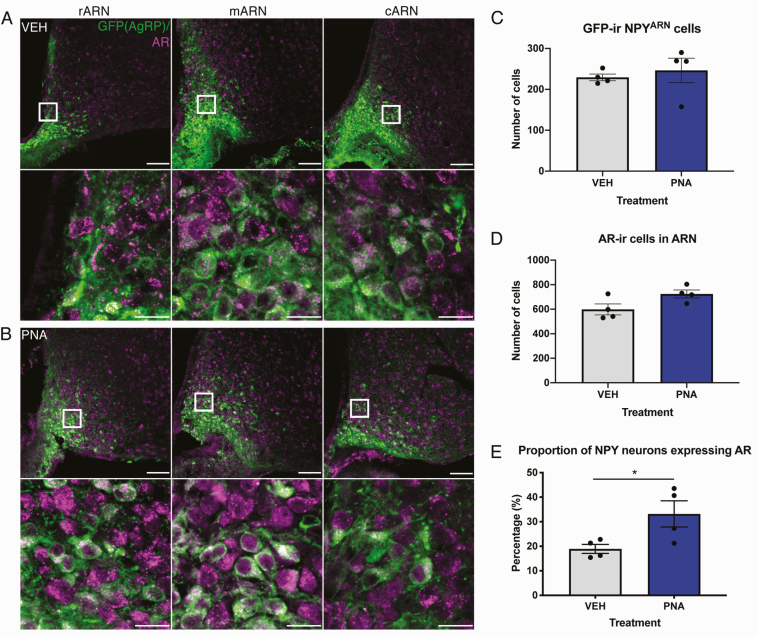

Expression of AR within NPY
ARN  neurons is elevated in PNA-treated mice. (A, top) Representative images composed from z-projections (6.36-µm thickness) collected throughout the ARN of a VEH-treated mouse showing AR-ir (magenta) and τGFP reporter expression of NPYARN neurons (green). (A, bottom) single plane high magnification images taken within the highlighted area indicated in the top row where GFP and AR labeling is observed. (B, top) Representative images composed from 6.36 µm thick z-projections containing AR and GFP-ir in the ARN of a PNA-treated mouse. (B, bottom) single plane high magnification images taken within the highlighted area. (C) Mean number of GFP-expressing NPY neurons counted in VEH- (gray bars, n = 4) and PNA-treated mice (blue bars, n = 4) across the whole ARN. (D) Mean number of AR-ir cells across the entire ARN in VEH- and PNA-treated mice. (D) The percentage of NPY neurons co-expressing AR in VEH- and PNA-treated mice, averaged across the whole ARN. Results are presented as mean ± SEM. * P < 0.05 as determined by Mann-Whitney U test. Scale bars = 100 µm (top), 10 µm (bottom).